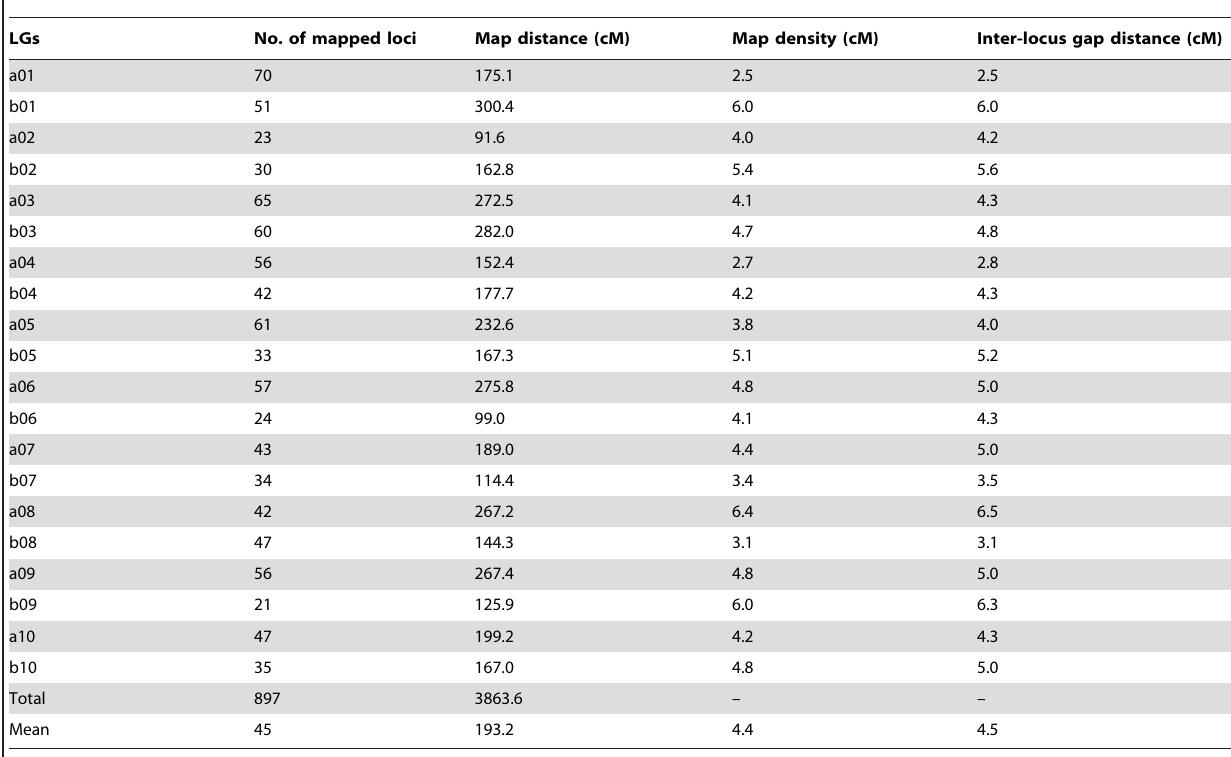
Table 4. Features of the reference consensus genetic map.